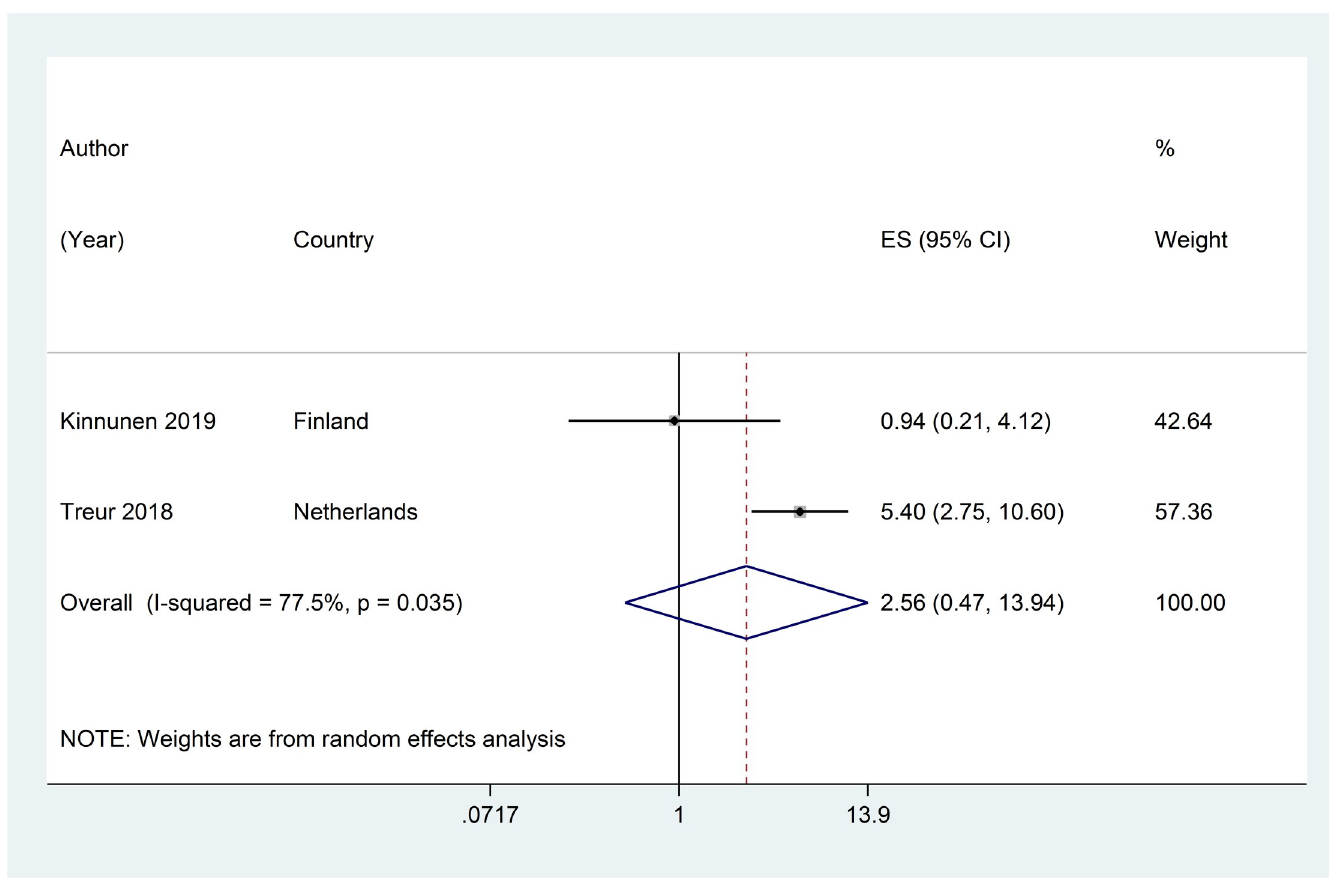
Fig 7. Forest plot of adjusted risk ratios assessing the association between ever ENNDS use at baseline and subsequent current or ever cigarette use at follow-up.